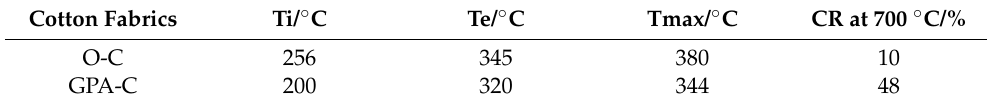
Table 3. TG parameters of cotton fabric